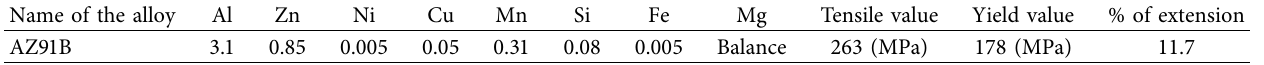
Table 1: AZ91B properties and compositions.